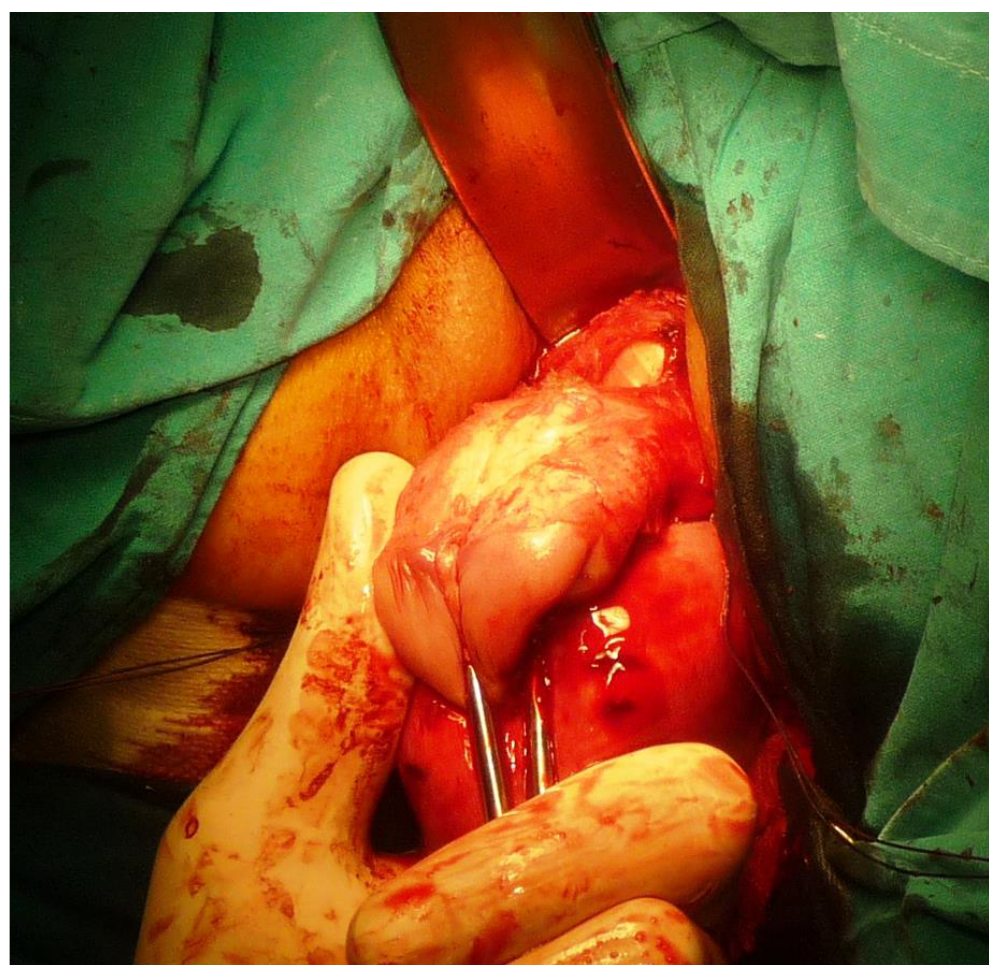
6. Opening the anterior peritoneum (Figure 6);